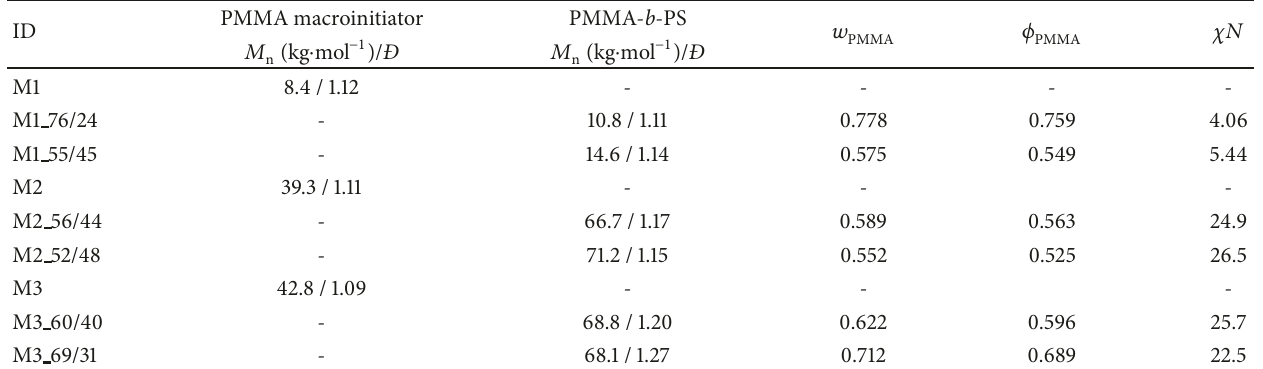
Table 1: Macromolecular characteristics and estimated properties of the investigated PMMA- b -PS